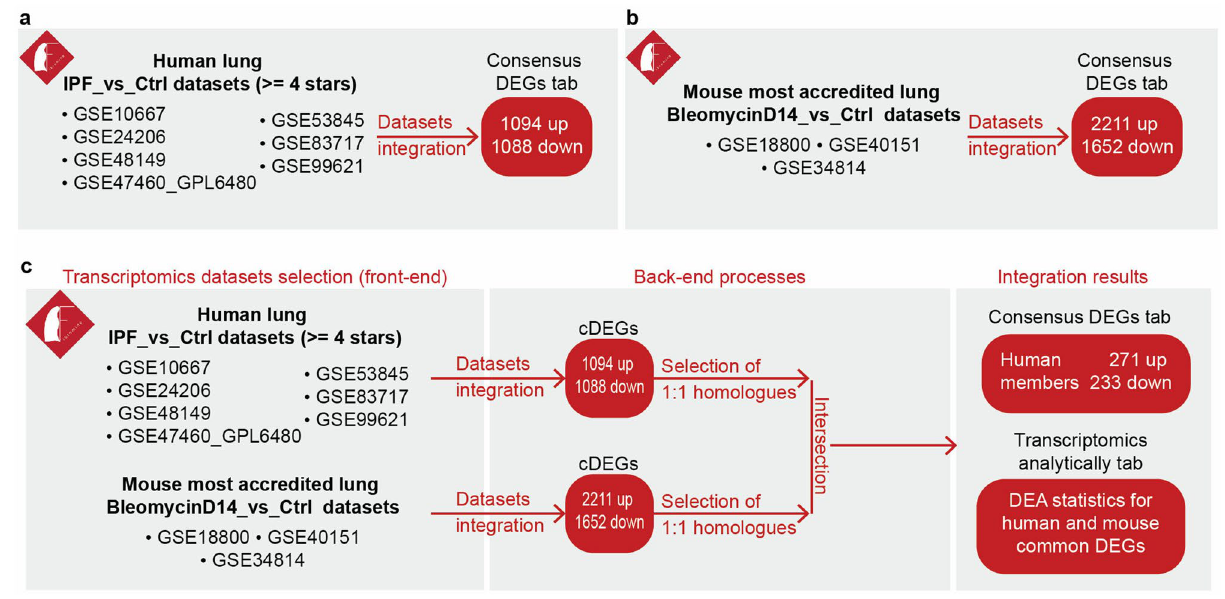
Figure 5. IPF_vs_Ctrl lung and BleomycinD14_vs_Ctrl datasets integration. (a) Integration of the IPF_vs_Ctrl lung datasets with at least 4 accreditation stars. (b) Integration of the top 3 starred BleomycinD14_vs_Ctrl datasets. (c) Across-species integration of the ( a,b ) datasets. Selection of the top accredited human and mouse transcriptomics datasets for integration leads to the identification of 504 consensus DEGs. All intermediate and integration output lists can be retrieved through Fibromine. Integration was performed using default differential expression thresholds. cDEGs: consensus differentially expressed genes, DEA: differential expression analysis. Figure was created using https:// www. google. com/ slides/